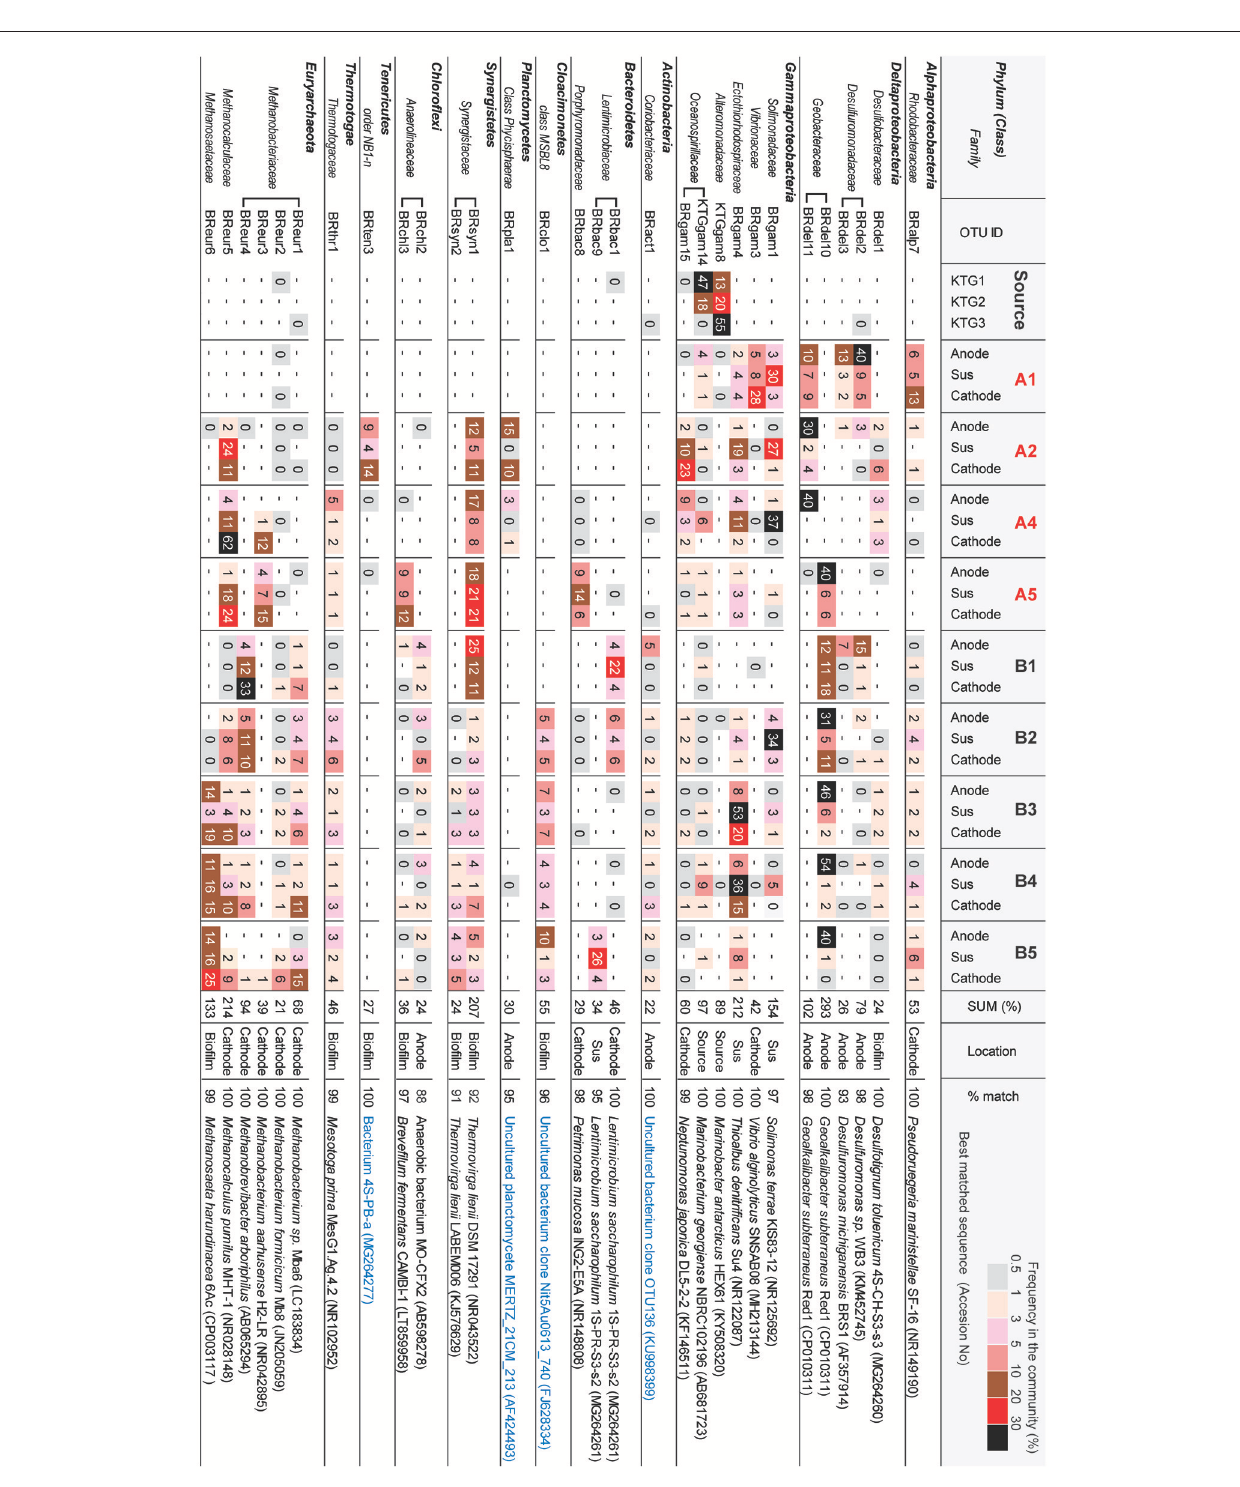
Frontiers in Energy Research |